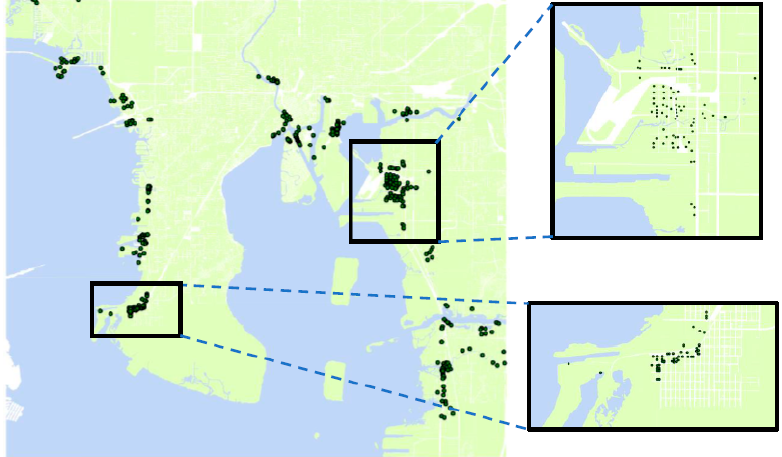
Figure 5. Flooded residential properties by 2150 in the high-end warming scenario. The most two flooded areas are detailed in the right two subfigures. Each black dot denotes one property to be flooded due to sea level rise.